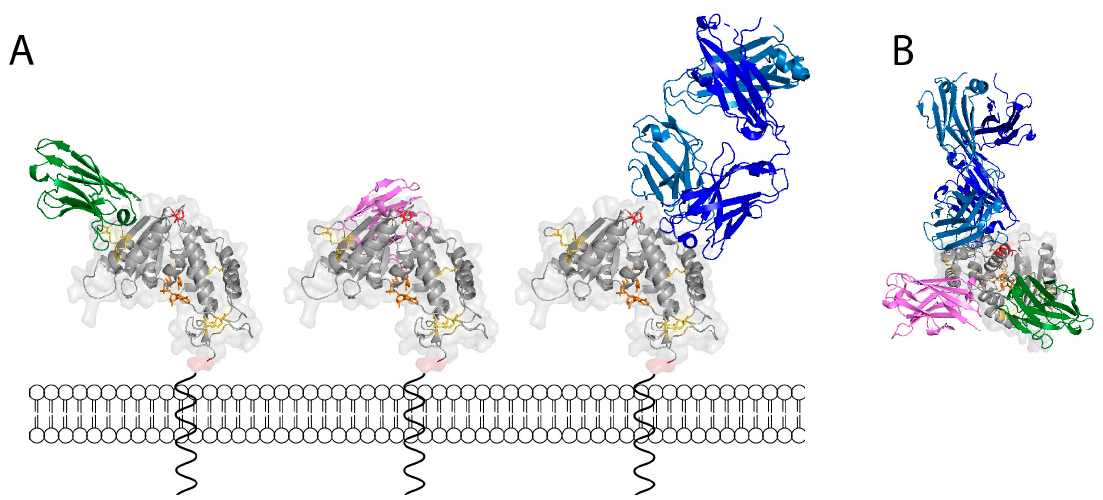
Figure 7. 3D models of CD38 with bound nanobodies MU375, MU523, and a Fab fragment of isatuximab. 3D-models of CD38 in complex with the epitope 1 nanobody MU375 (green), epitope 2 nanobody MU523 (magenta), and the Fab fragment of isatuximab (heavy chain dark blue, light chain lighter blue) were generated by PyMol, using data from PDB files 5f21, 5f1o, and 4cmh. CD38 is depicted in the same orientation and color coding as in Figure 4 (with 5 conserved disulfide bonds in yellow, the non-conserved disulfide bond at C119/C201 in red, NAD + in the active site crevice in orange, and the N-terminal amino acid of the extracellular domain in transparent red). The N-terminal cytosolic domain and transmembrane domain are depicted schematically. The models in ( A ) show CD38 as viewed in the plane of the cell membrane, the model in ( B ) shows CD38 as viewed from the "top" with the cell membrane "below" CD38.